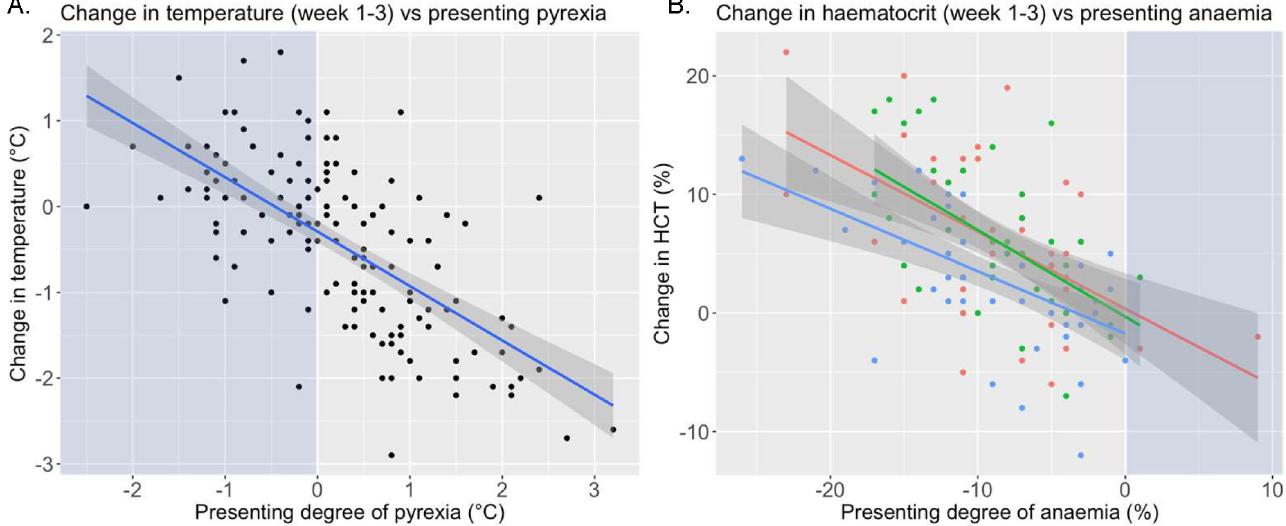
Fig 3. Scatterplots illustrating the change in clinical parameters from week 1 to 3. A. Scatterplot showing individual changes in rectal temperature for whole treatment trial population (n = 162) following treatment. The regression line is marked in blue with 95% confidence intervals in dark grey. Light blue background shading illustrates animals presenting with parameters within reference range. B. Scatterplot showing individual changes in HCT, with colour coding to illustrate trypanocidal treatment group (melarsomine dihydrochloride = blue, diminazene = red and isometamidium = green) for whole treatment trial population (n = 162) following treatment. The regression line colour represents the trypanocide with 95% confidence intervals shown in dark grey. Presenting degree of anaemia (%) calculated by the difference between the animal’s HCT and the lower end of species appropriate reference values (donkey 27%; horse 31%).